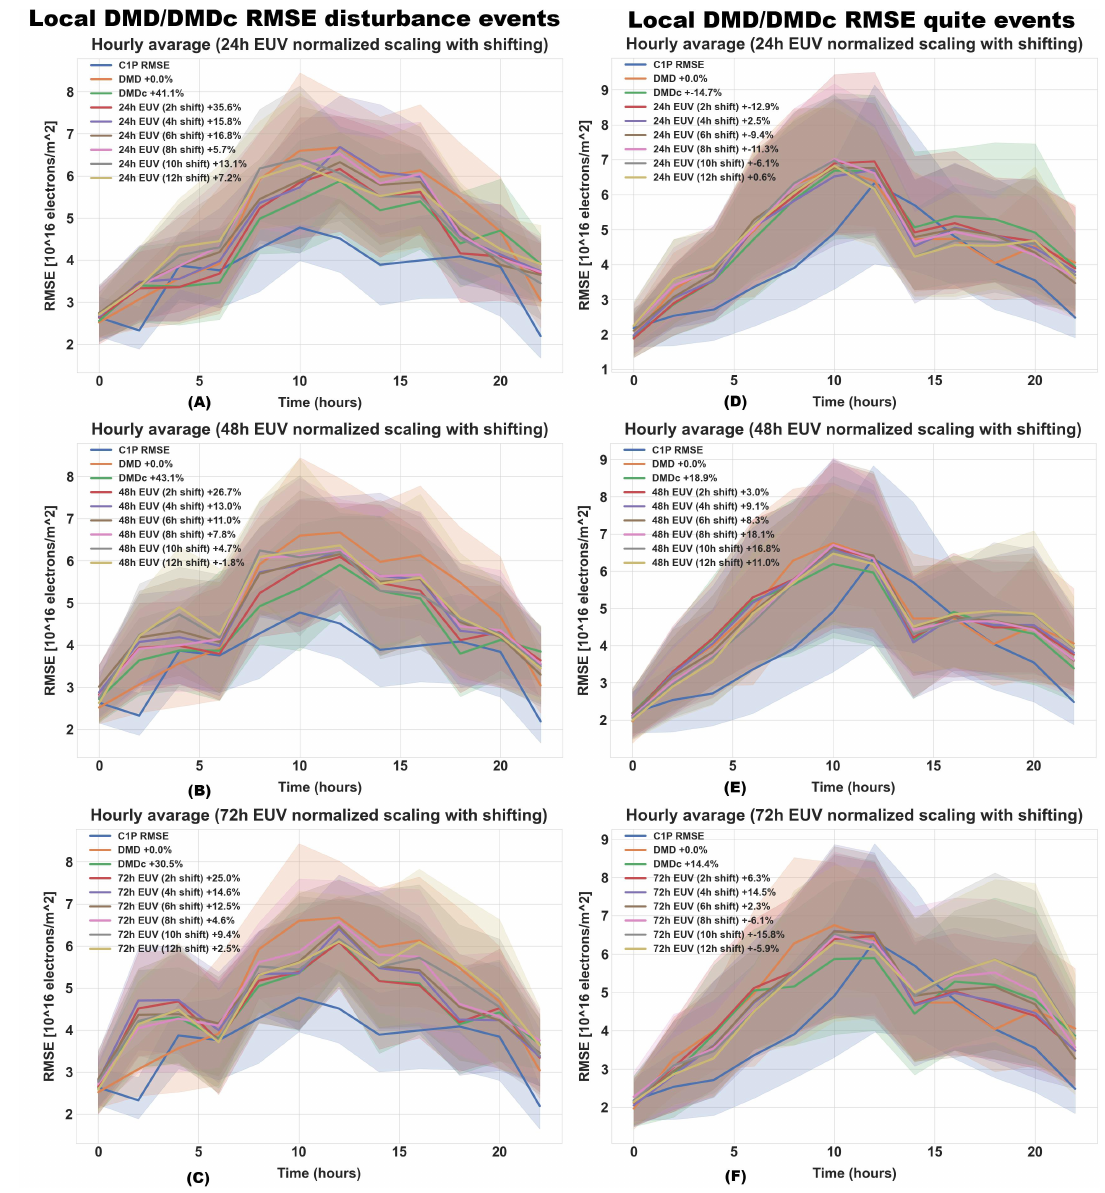
Figure 9. LIMs RMSE evaluation plot for the DMD, DMDc, and C1P predictions with 2-h candidate. On the left side, sub-figure group ( A – C ) present the LIMs vTEC RMSE for the disturbed solar activity case studies with length parameters: 24, 48, and 72, respectively. On the right side, sub-figure group ( D – F ) present the LIMs vTEC RMSE for the quiet solar activity case studies with length parameters: 24, 48, and 72, respectively. The sub-figures present the examined shift parameters of the control input signal and its improvement over the DMD model. Note that the DMDc has a zero shift